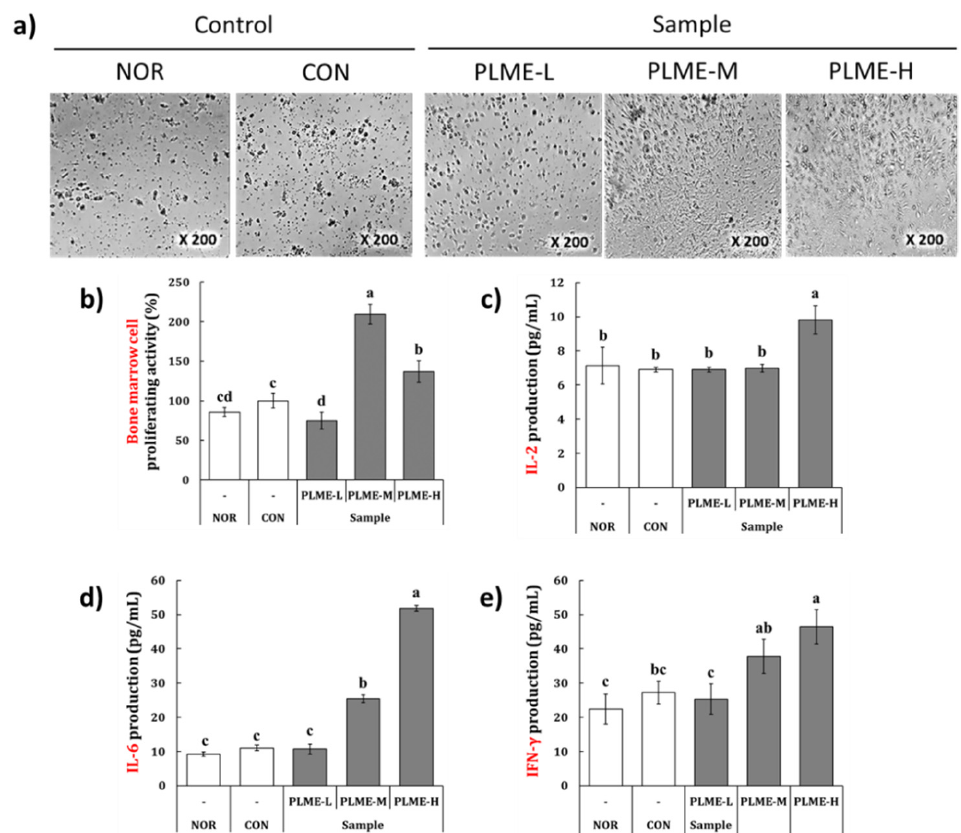
Figure 5. The effect of PLME administration on the intestinal immune system-modulating activity. The Peyer’s patch cells were isolated from mice administered with PLME and artificially incubated for five days, and bone marrow cell proliferation through Peyer’s patch and cytokine production from Peyer’s patch were determined by MTT assay and ELISA, respectively. ( a ) Representative microscopic images of bone marrow cells inoculated Peyer’s patch cell-cultured supernatant. ( b ) Bone marrow cell proliferating activity was determined using MTT assay. ( c – e ) The levels of cytokines from Peyer’s patch cells were determined using ELISA. Different letters indicate a significant difference among groups ( p < 0.05) using Tukey’s multiple range test. NOR, normal group administered tap water; CON, medium control group administered only culture medium (250 mg/kg/day); PLME-L, PLME-M, and PLME-H, sample groups administered postbiotics prepared from P. linteus mycelial submerged culture at doses of 250, 500, and 1000 mg/kg bw/day,